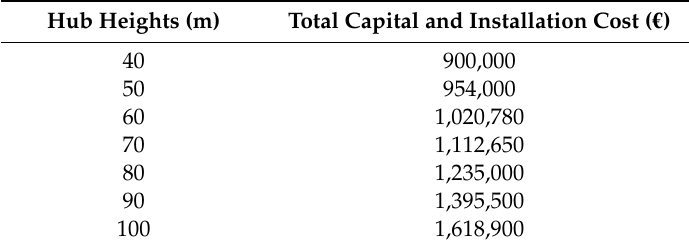
Table 3. Incremental cost of the 1 MW wind turbine. Source: Rehman et al. [8]. Hub Heights (m)